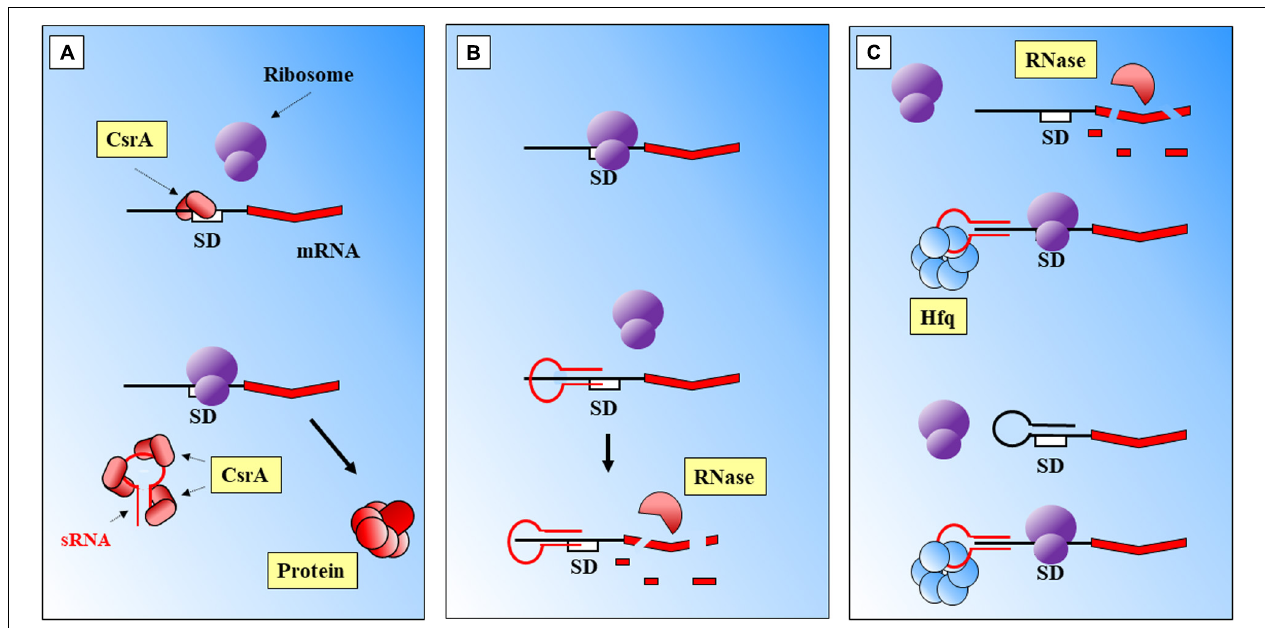
FIGURE 1 | Main modes of action of prokaryotic sRNAs. (A) sRNA binding to a CsrA regulatory protein frees the SD region. (B) Direct sRNA-mRNA binding. The shown sRNA competes with the ribosome, which cannot bind to the SD site. The mRNA is further degraded. (C) Protein mediation. Hfq-sRNA bind to the mRNA and stabilize it, and degradation is prevented. The complex protein-sRNA can unfold secondary structures in the 5 (cid:48) UTR which will prevent ribosome binding. SD, Shine-Dalgarno. Black thick arrows indicate flow of a biological process, e.g., protein translation. References: Massé et al., 2003; Waters and Storz, 2009; Faucher and Shuman, 2011; Chakravarty and Massé,